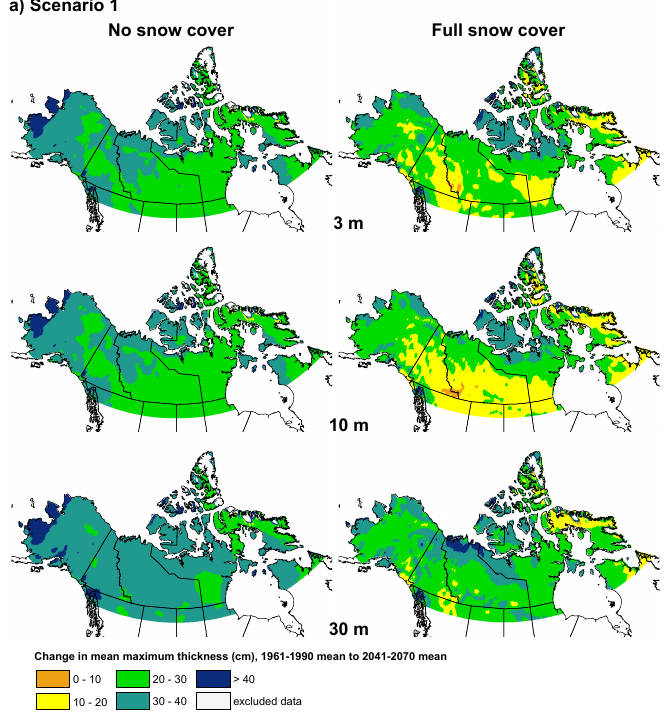
Fig. 14a. Change in mean maximum thickness 1961–1990 to 2041–2070 for (a) scenario 1; (b) scenario 2; (c) the difference between the scenarios for the 2041–2070 mean maximum